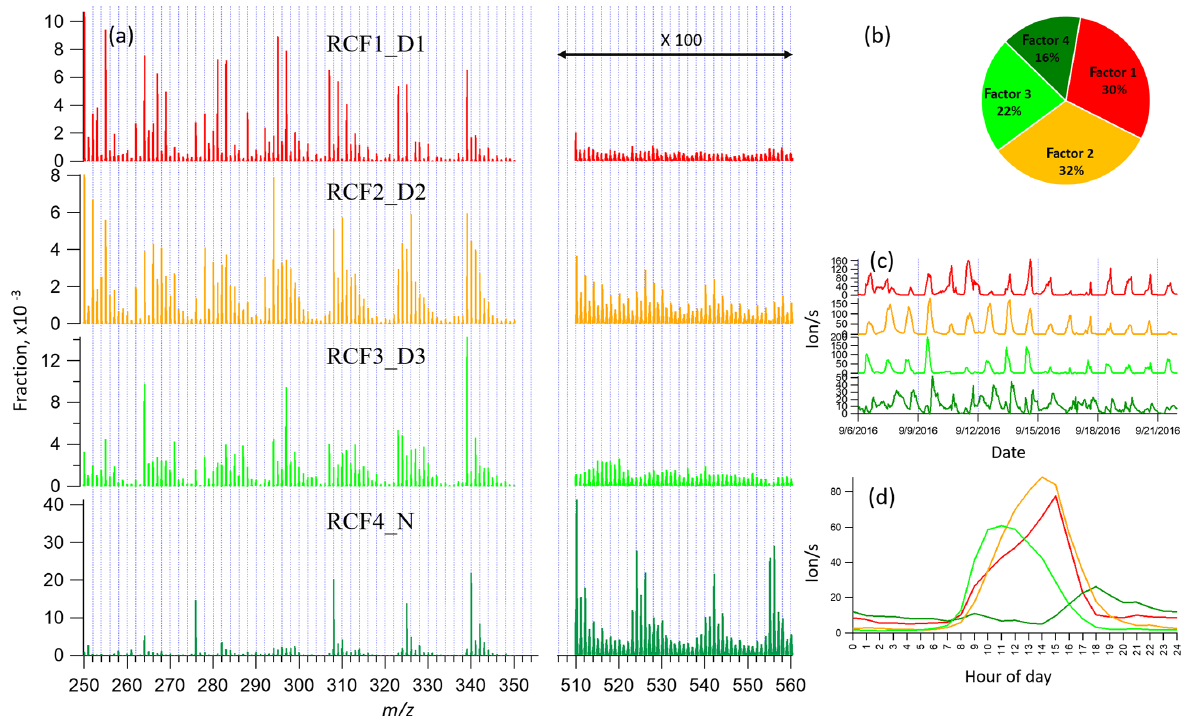
Figure 5. Four-factor result for Range combined for (a) factor spectral profiles, (b) averaged factor contribution during the campaign, (c) time series, and (d) diurnal trend. Details on the naming schemes for the factors are shown in Table